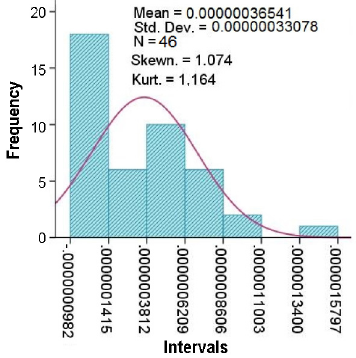
Fig. 10. Histogram of water permeability without outliers and statistical indicators